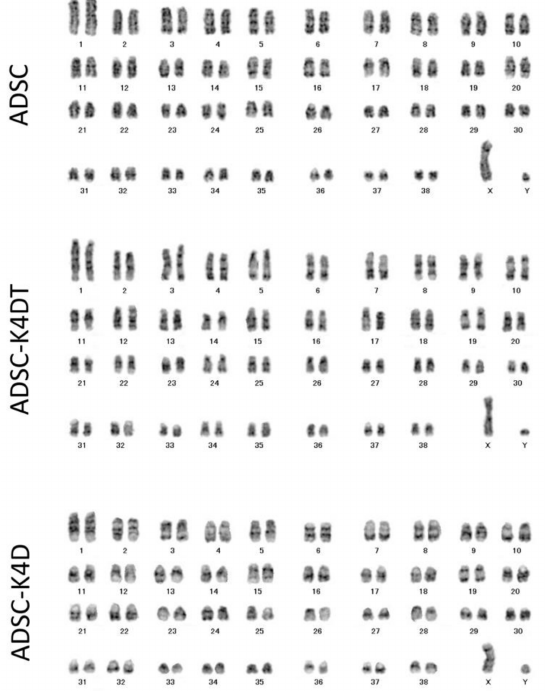
Figure 8. Karyotype analyses of the ADSC-K4DT and ADSC-K4D cells. Aligned chromosomes of the primary ADSCs, and the ADSC-K4DT and ADSC-K4D cells are shown. All cells had a 2 n = 76 + XY